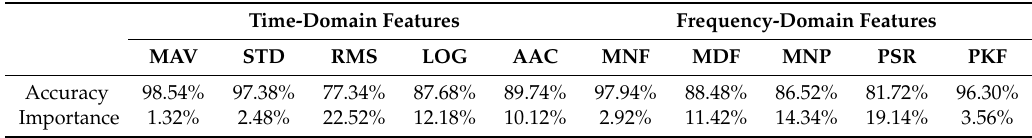
Table 3. The importance of selected ten features.